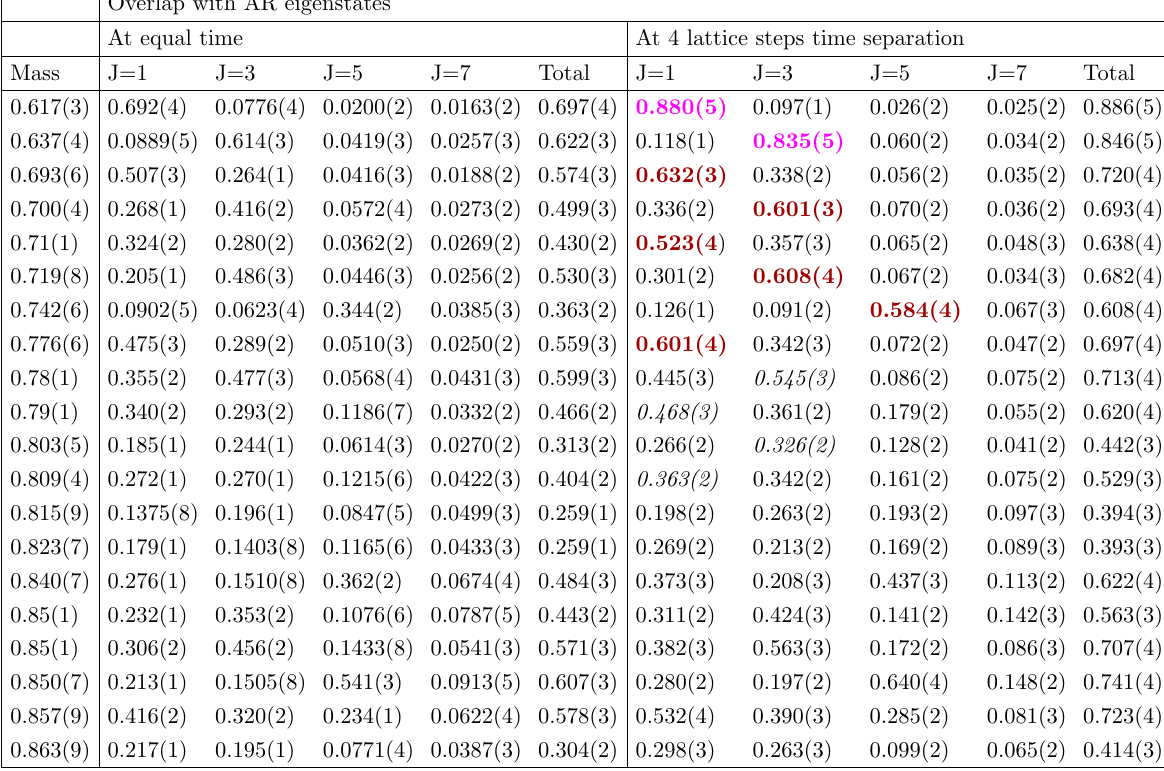
Table 16. Masses from glueballs in E representations with C = (cid:0) and averaged over parity, using conventional operators and overlaps with AR